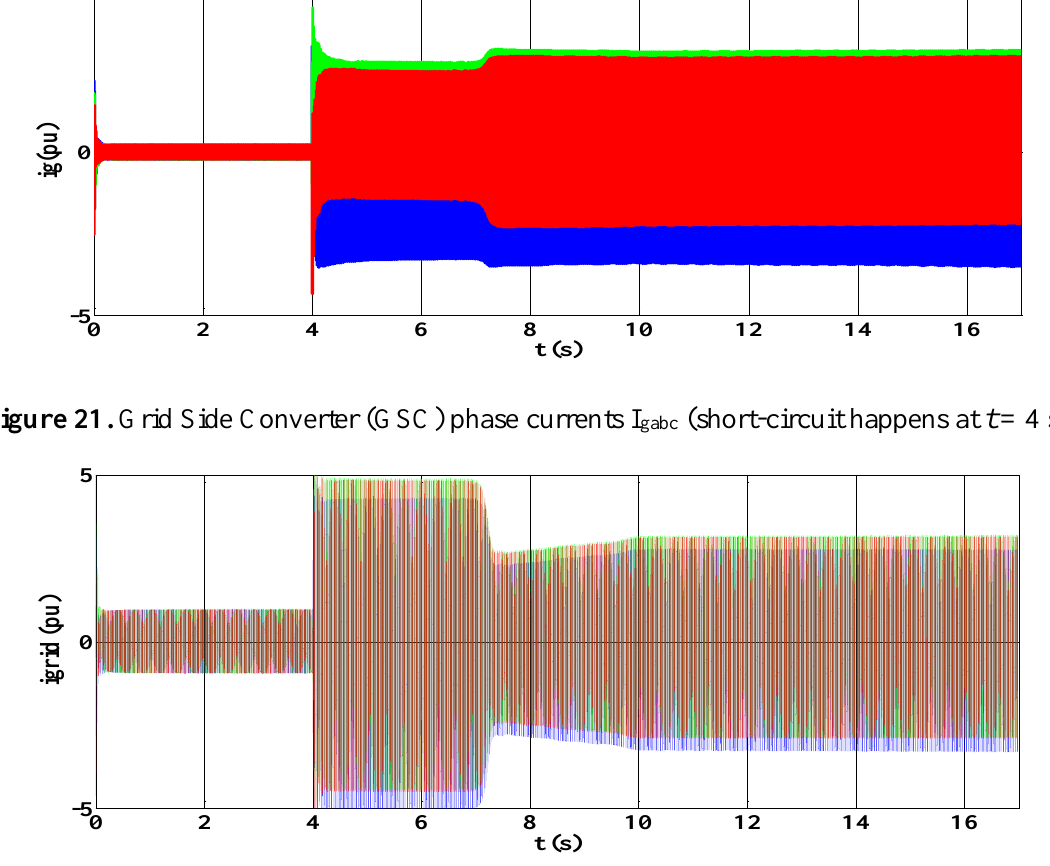
Figure 22. Grid phase currents I gridabc (short-circuit happens at t = 4